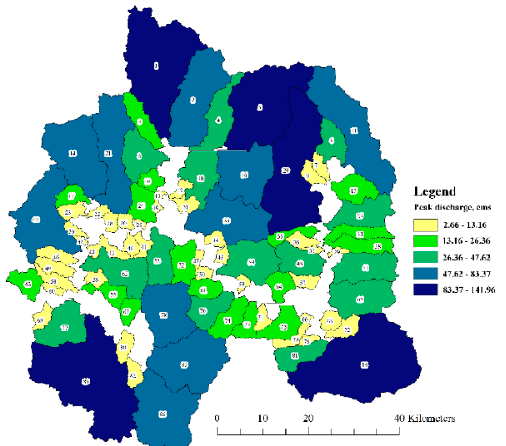
Figure 11. Peak discharge of sub-watershed in the study.